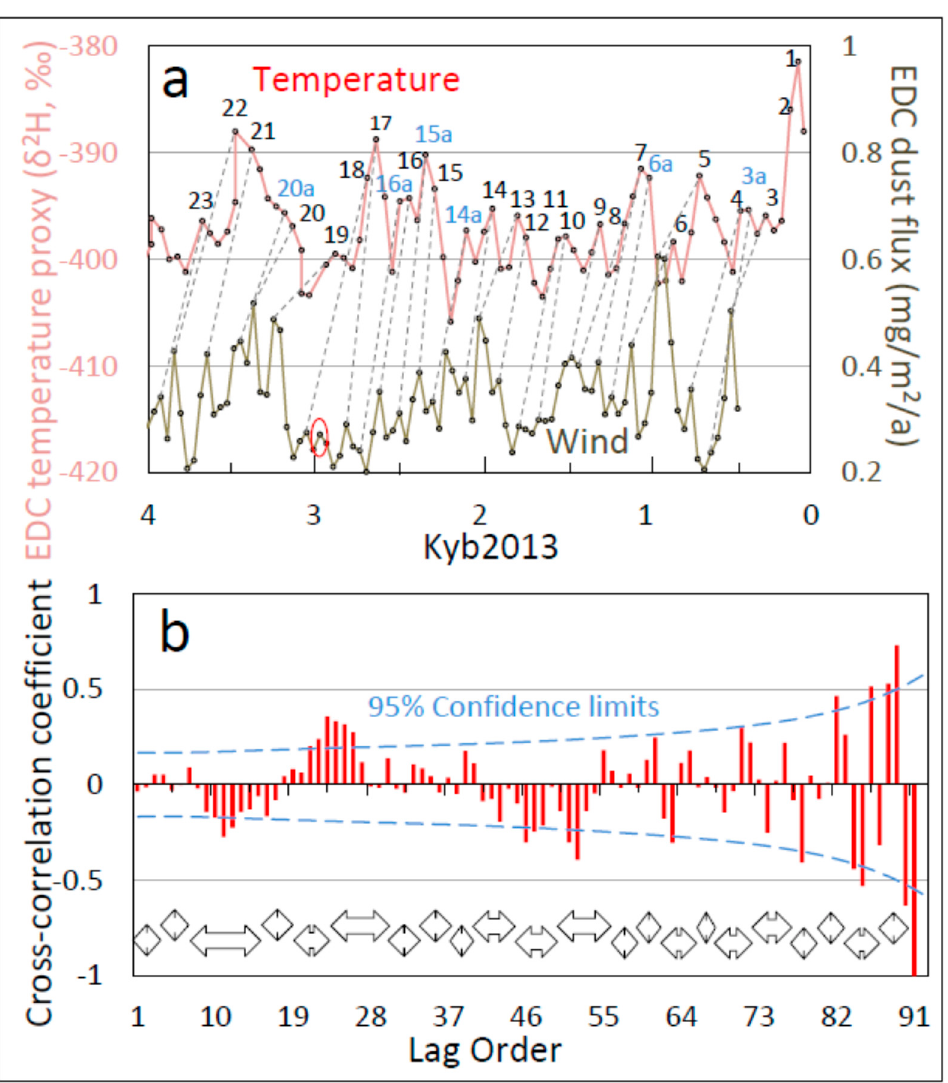
Figure 1. One-to-one coupling between identified temperature-proxy oscillations at EPICA Dome C (EDC) and dust flux (a wind proxy) at EDC for the last four millennia. ( a ) 1:1 correspondence between wind-proxy cycles and identified temperature-proxy cycles, connected by dashed lines to assist visualization of cross-record coherence. Each wind peak corresponds 1:1 with the indicated temperature peak. EDC temperature peaks are labeled following the numbering protocol developed for corresponding peaks at Vostok [12,13] ( b ) Cross-correlation between temperature proxies and dust flux at EDC over the period 4000-375 years before 2013 (Yb2013). The dashed blue lines in part b represent 95% confidence limits (positive and negative) for the value of the correlation coefficient associated with different lag orders (sample sizes). Double-headed arrows demarcate the underlying centennial-scale periodicity determined from the cross-correlation record. The cross-correlation is statistically discernible in most (52.4%) cycles, ranging in magnitude from weak to moderate.